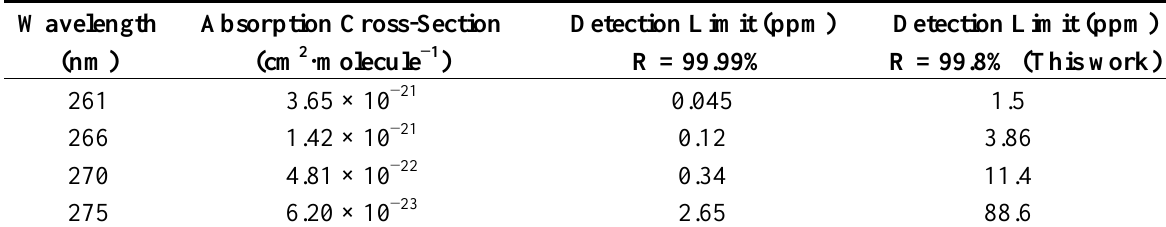
Table 2. Detection limits of isoprene with the present CRDS system with mirror reflectivities R = 99.99 and